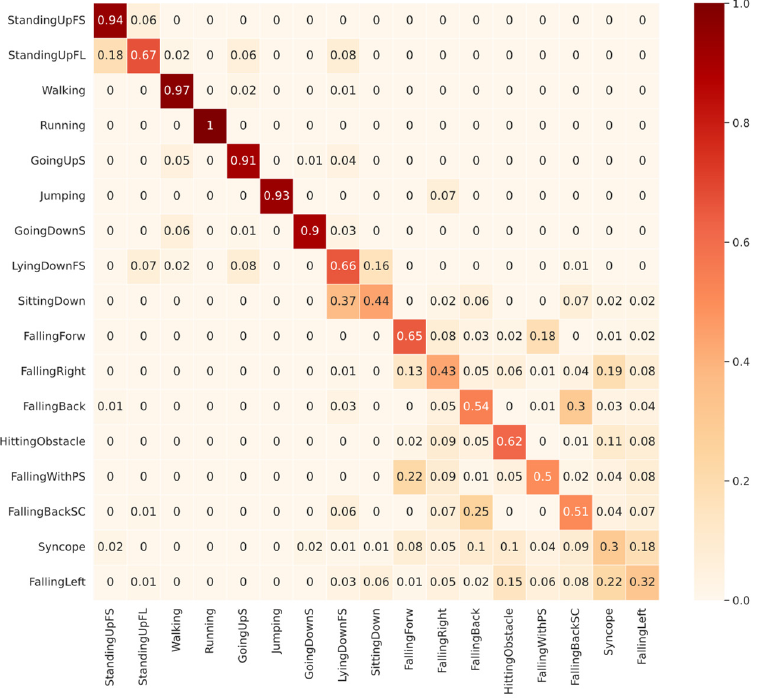
Figure 7. Confusion Matrix of CNN1 with subject-independent with 9 subjects in validation for all 17 classes in UniMiB-SHAR